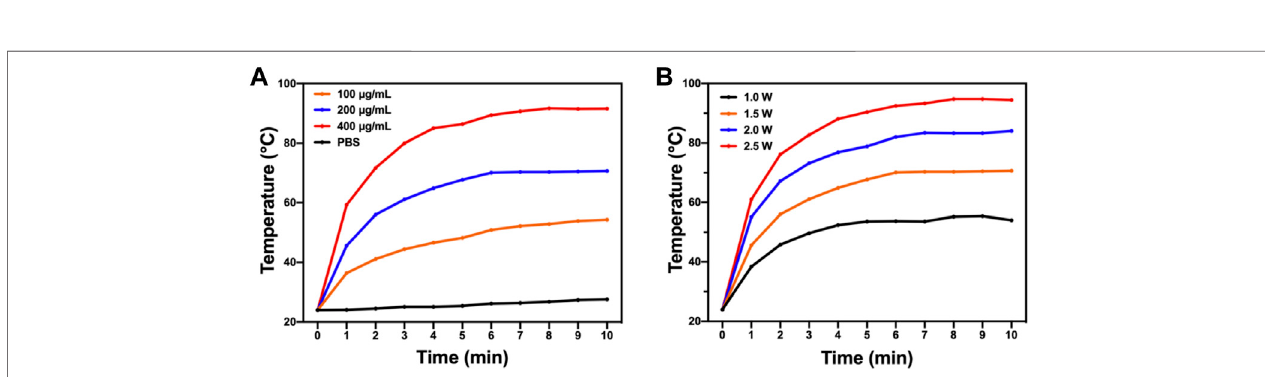
FIGURE 6 | Photothermal property of BAPTCDs. (A) Temperature change of BAPTCDs aqueous with different concentrations upon 10 min of 808 nm laser irradiation (power density = 1.5 W/cm 2 ). (B) BAPTCDs at the concentration of 200 μ g/ml with a series of power densities of 808 nm laser irradiation.